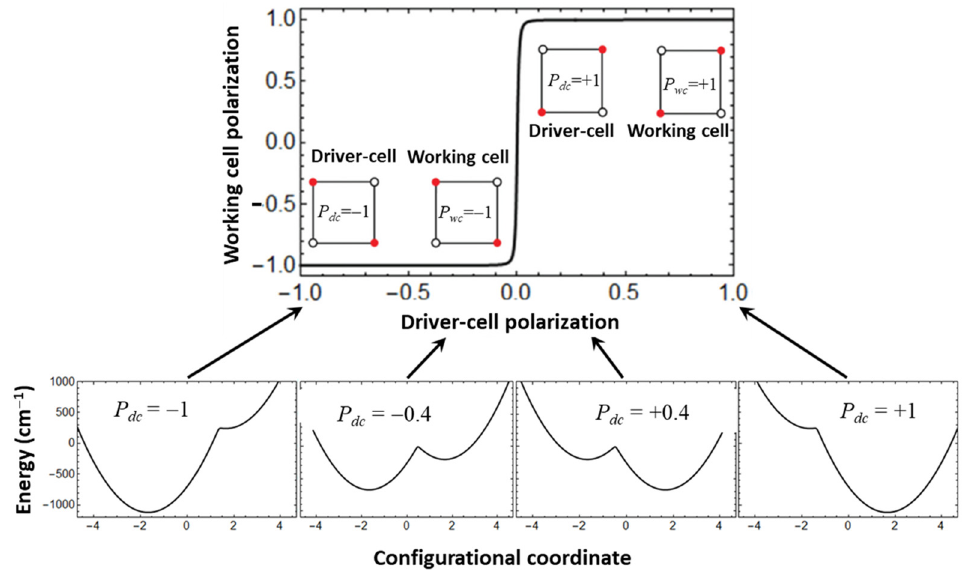
Figure 2. Illustration for the strongly non-linear cell-cell response (upper part) accompanied by corresponding semiclassical representation of the switching cycle showing the evolution of the lower branch U − ( q ) of the adiabatic potential of the working cell caused by the change of the driver cell polarization (lower part). Cell polarizations range from − 1 (binary 0 ) to +1 (binary 1 ). For the sake of utmost clarity, the case of one-dimensional adiabatic potential is shown.